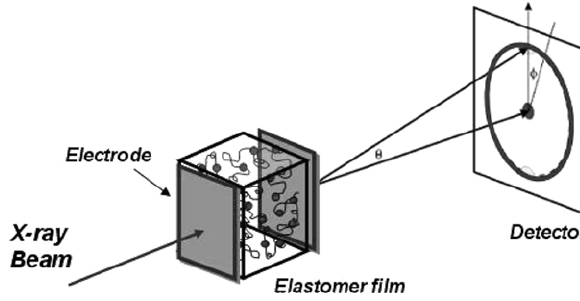
Figure 16: A schematic of an electromechanical strain measurement by using an in situ synchrotron SAXS [100]